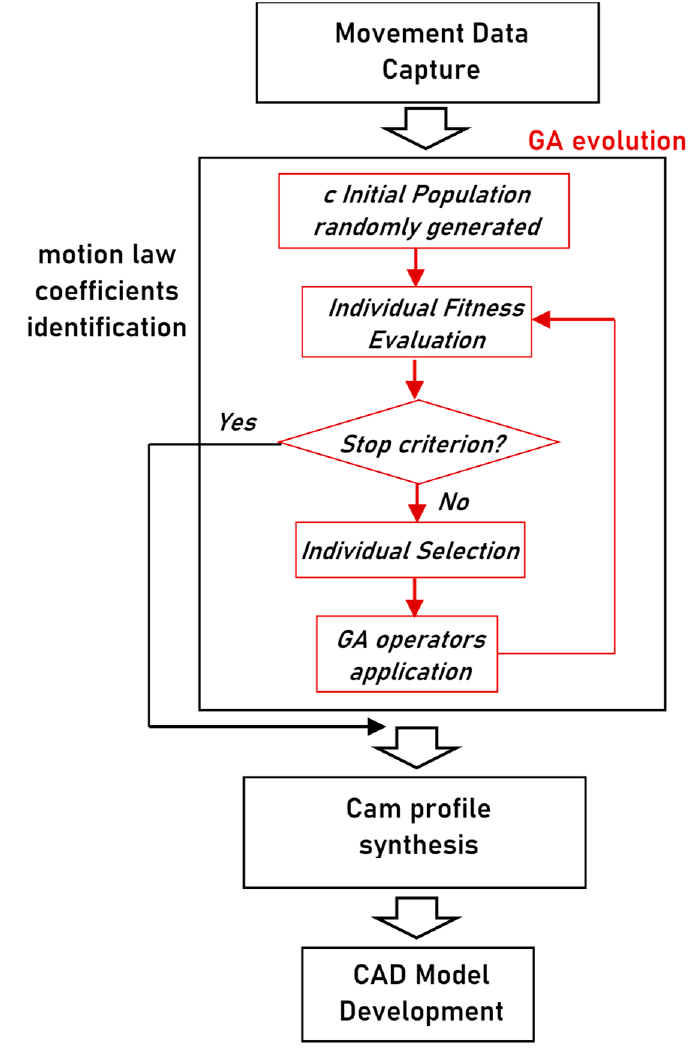
Figure 7. Flowchart of the developed cam mechanism